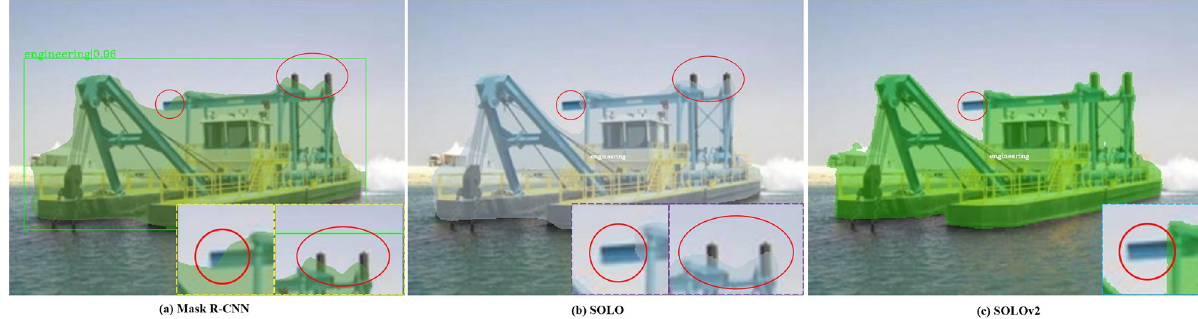
Fig 11. A representative example of incomplete segmentation by Mask R-CNN, SOLO and SOLOv2. The red circles represent the parts of ships that should be detected but are not detected. Insets: amplified images of the objects with the red circles.